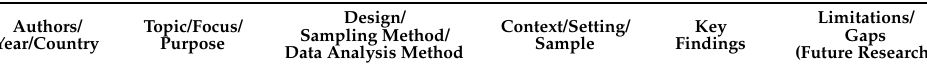
Table 2. Data Extraction